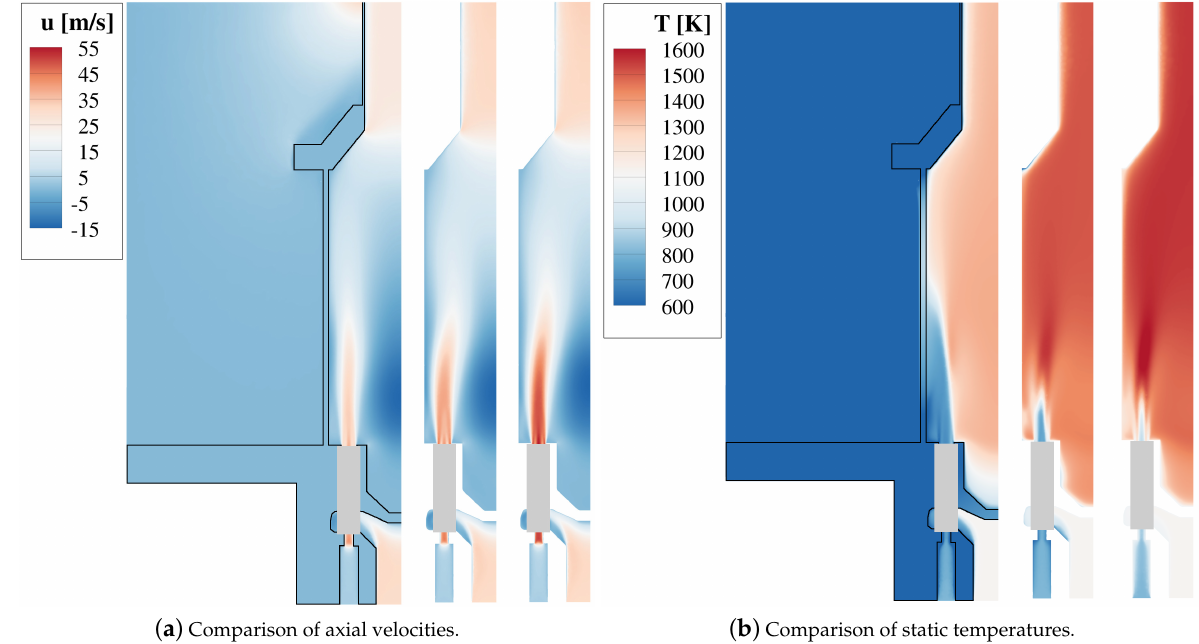
Figure 7. Combustor mid-plane of numerical results. Left : fully-coupled CHT, mid : Heat-flux modeled, right : isothermal